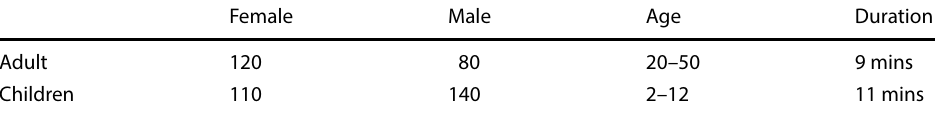
Table 1 LimitAccess Dataset breakdown